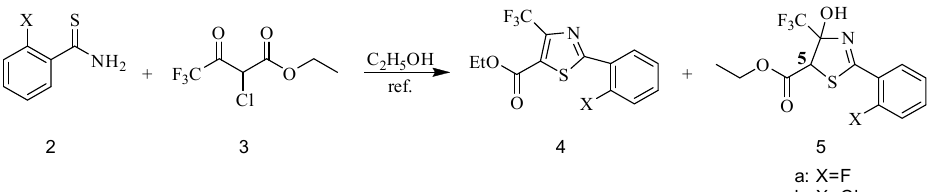
Scheme 1. Synthetic pathway for the preparation of 4 and 5 .